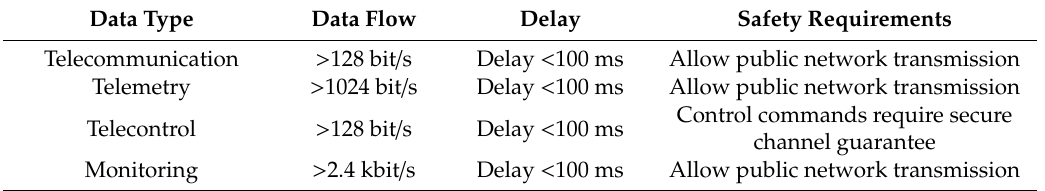
Table 4. Communication requirements.